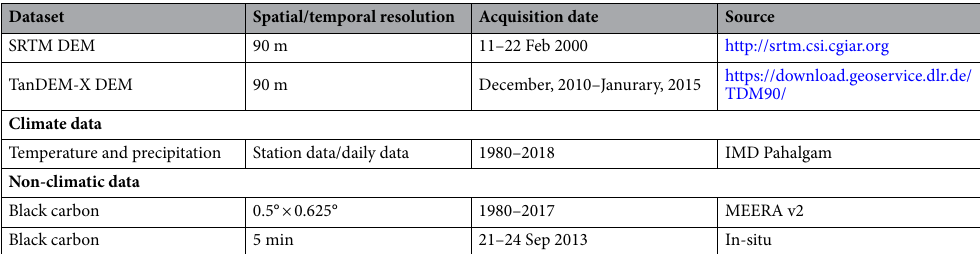
Table 1. Description of the datasets used in this